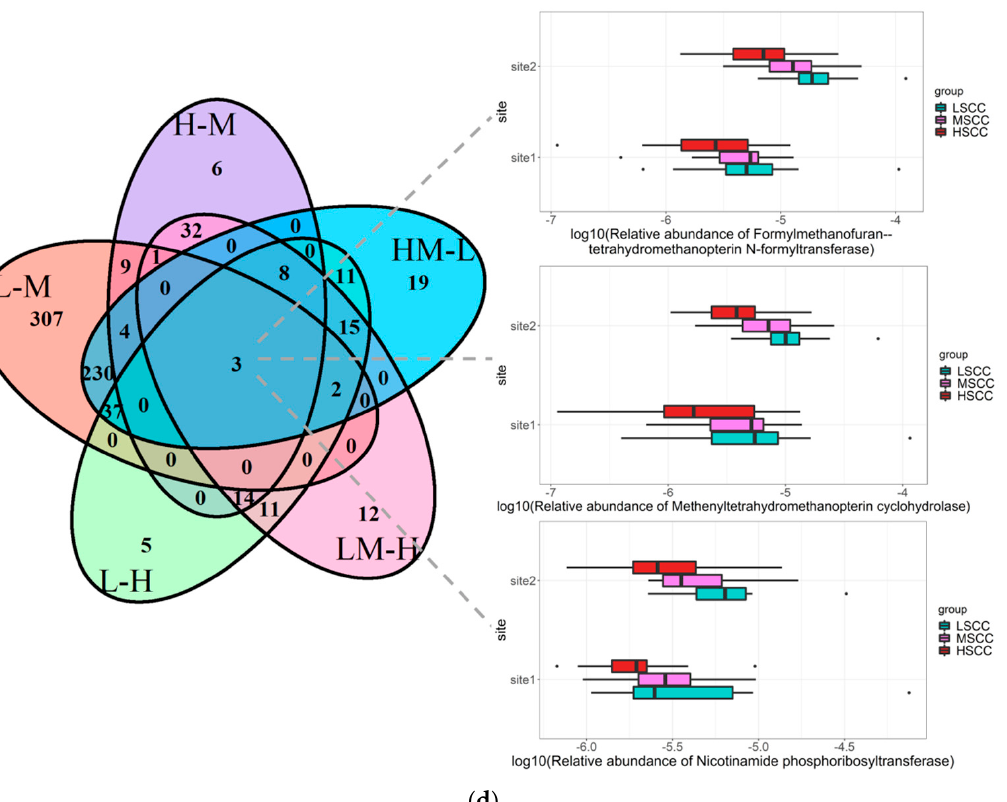
Figure 4. Differentially abundant genera and metabolic pathways obtained by pairwise comparison ( a ) Differentially abundant genera identified in each comparison. ( b , c ) Boxplot showing log10-transformed relative abundance of two most significantly differentially abundant genera between LSCC and MSCC ( d ) Venn diagram showing the number of the predicted metabolic pathways identified as significantly differentially abundant in each comparison and log10-transformed relative abundance of pathways that were shared in all comparisons. H − M: HSCC vs. MSCC, L − M: LSCC vs. MSCC, L − H: LSCC vs. HSCC.